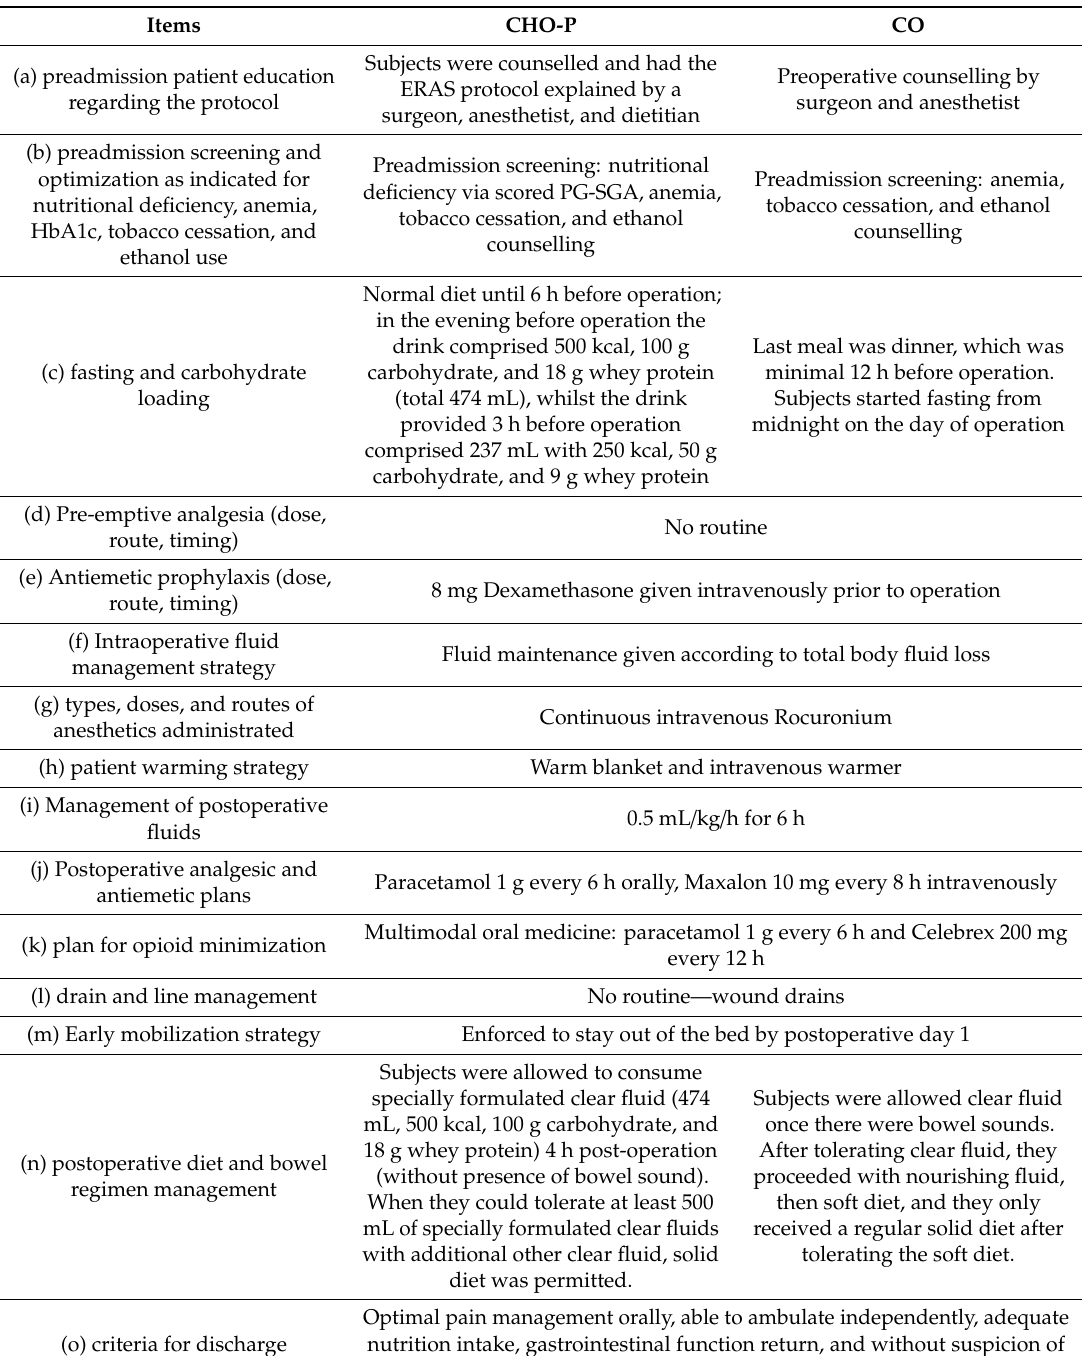
Table 1. Comparison of the study protocol between the intervention group (CHO-P) under Enhanced Recovery after Surgery* and control group (CO) under conventional perioperative